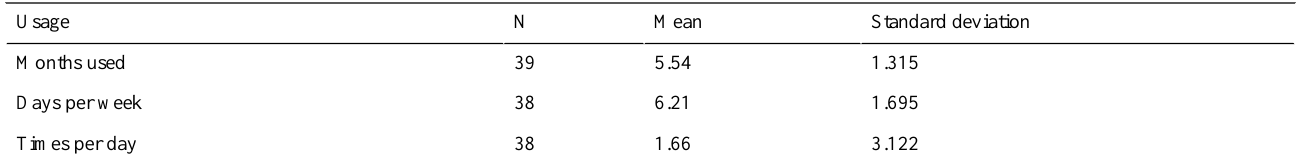
Table 2. Respondents’answers to survey question: “Over the six month Gray Matters intervention period (April 2014 – October 2014), how often did you use the